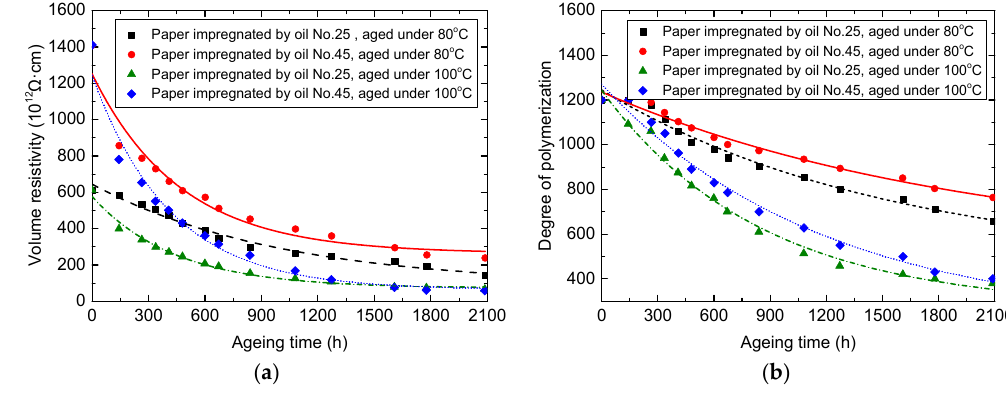
Figure 1. Measured resistivities and DP values at different ageing stages in [37]. ( a ) Measured resistivities under different ageing stage; ( b ) Measured DP values under different ageing stage. With the measured data in Figure 1, relationships between degree of polymerization and volume resistivity of oil impregnated paper were built, as shown in Figure 2. There are good power function relationships between the degree of polymerization and volume resistivity for different kinds of paper. Table 1 provided the parameters of the power fitting curves.